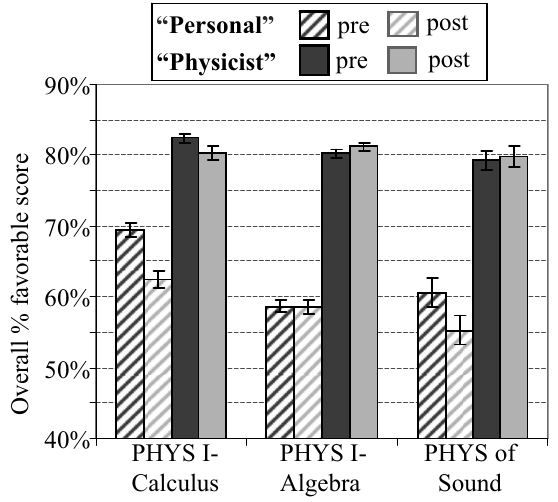
FIG. 2. CLASS overall percentage favorable scores by course. For each of the three courses surveyed, the average overall percent- age favorable “personal” scores—what the students believe about physics—are significantly lower than the “physicist” scores—what and